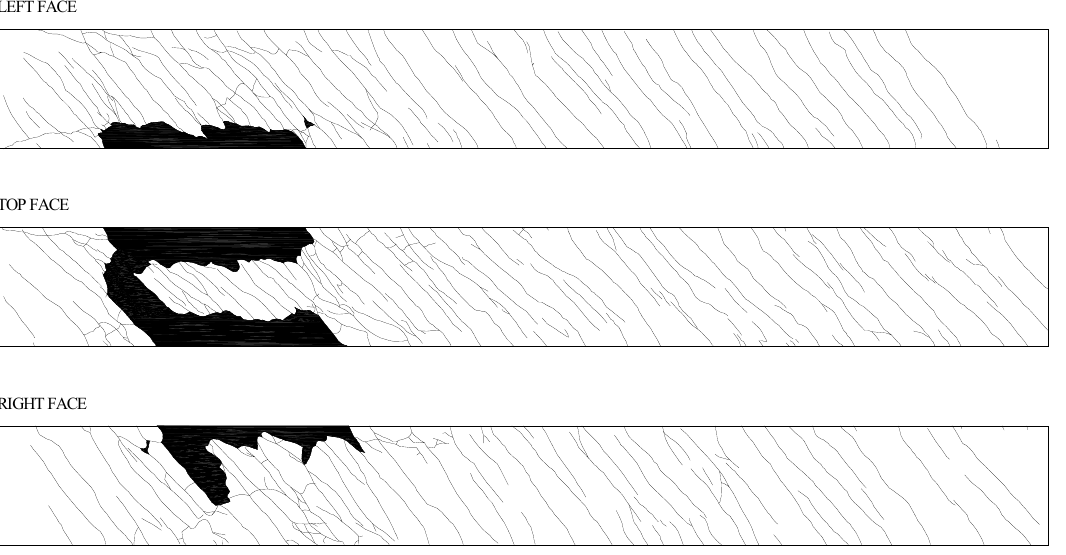
Figure 13. Cracking pattern: Beam D-1.79.